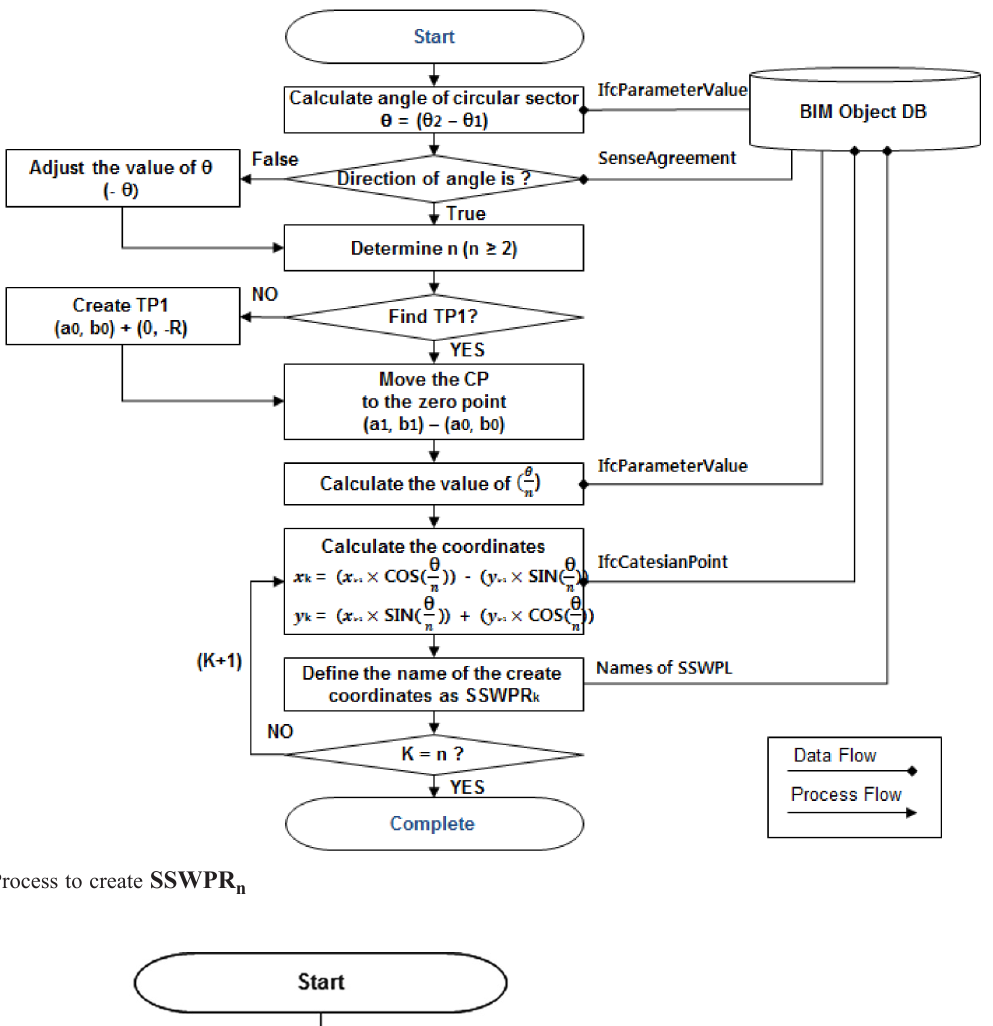
Fig. 6. Process to create SSWPR n